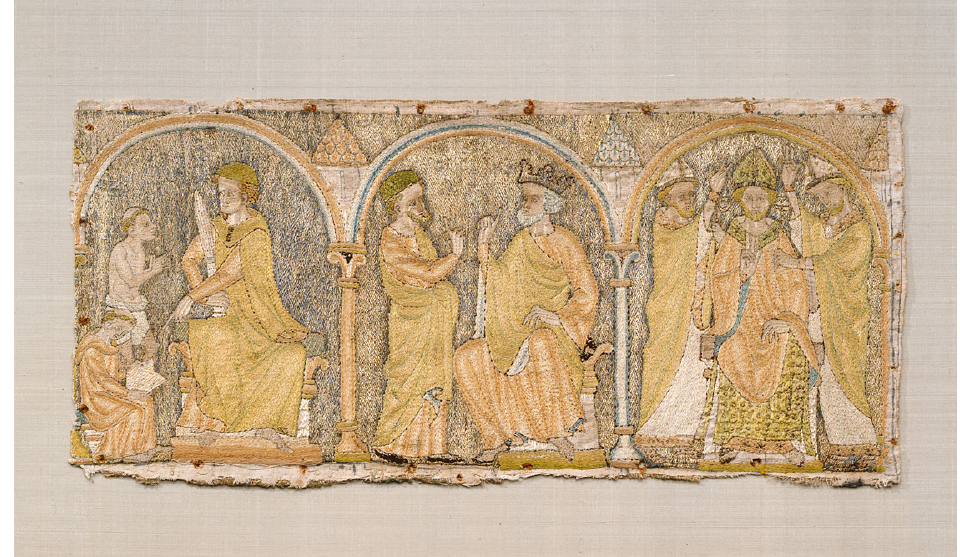
Figure 9. First embroidered panel, Thomas Becket’s hagiographic cycle, second half of the 13th Century. Abegg-Stiftung Foundation, Switzerland. © Abegg-Stiftung, CH-3132 Riggisberg, 2008. Photo: Christoph von Viràg.